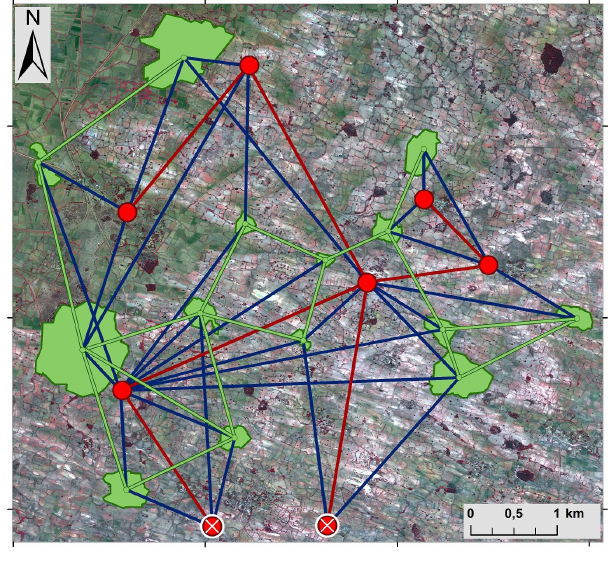
Fig. 3 . Social-ecological network of forest patches, clans, and their different interrelationships in an agricultural landscape in southern Madagascar. The red nodes represent clans residing in the landscape, and the green nodes forest patches. The tiers between clans represent various forms of social relations, the ties between clans and forest patches represent use and managerial responsibilities, and the ties between the forest patches represent seed dispersals (figure from Bodin and Tengö